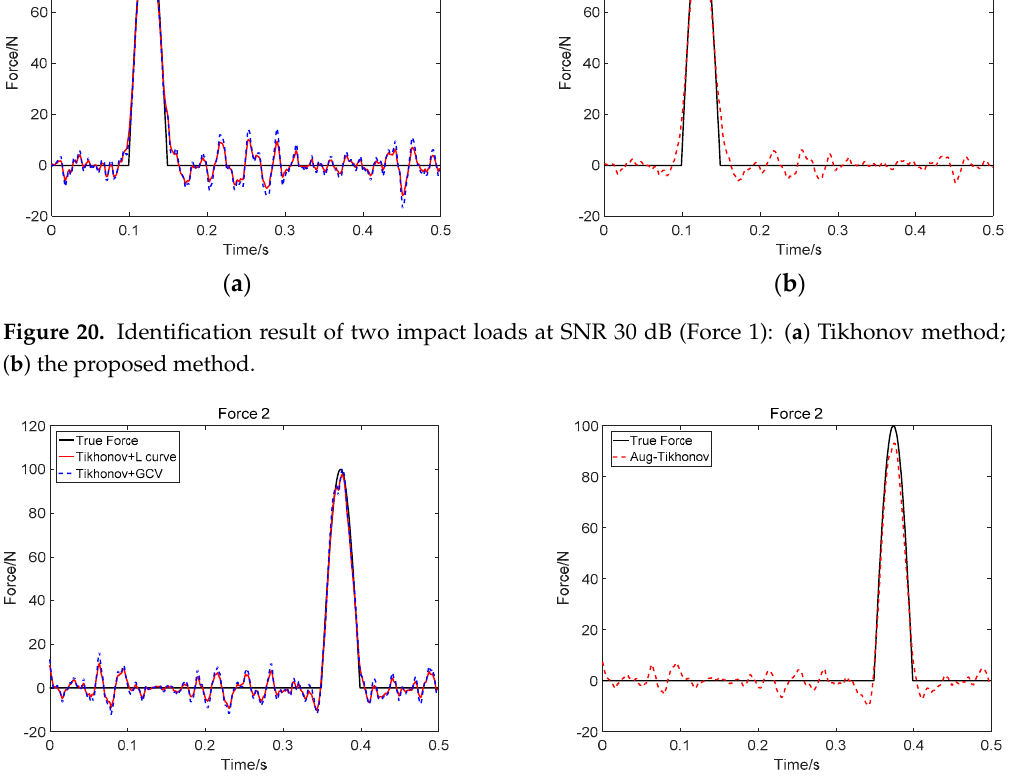
Figure 21. Identification result of two impact loads at SNR 30 dB (Force 2): ( a ) Tikhonov method; ( b ) the proposed method. Table 2. Identification effect of two sinusoidal loads.